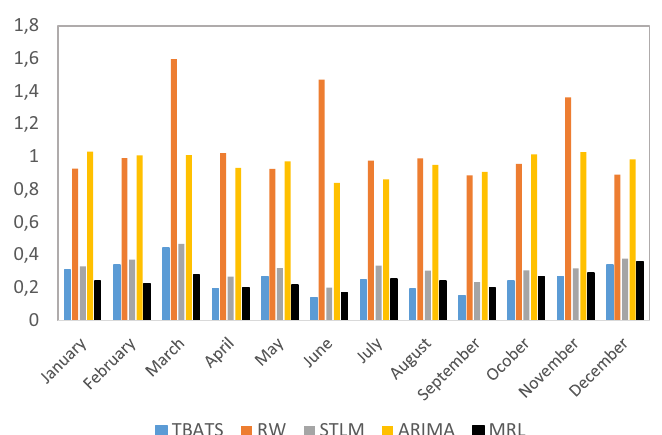
Fig. 12 RMSE daily forecasting rolling scheme month by